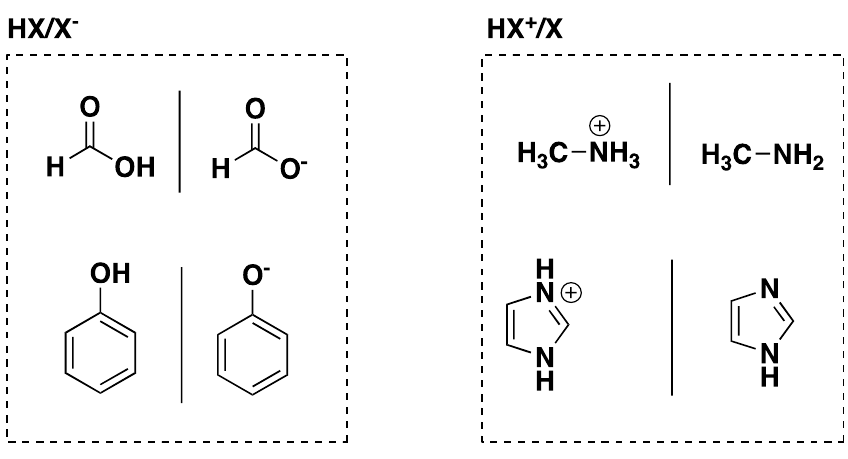
Figure 1. Structures of acids examined in this work.